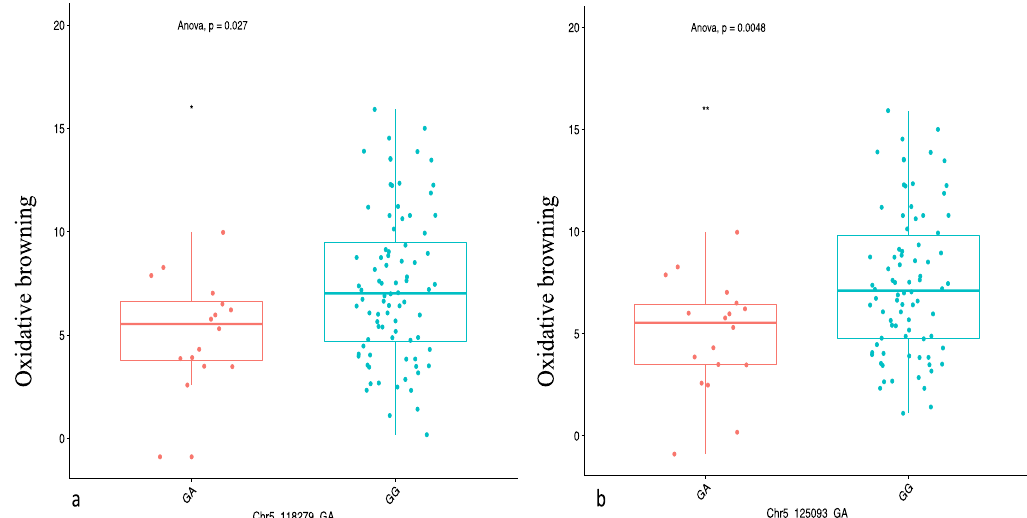
Figure 6. Marker effect of the significant markers associated with OxB on chromosome 5 with two markers: ( a ) chr5_118279 and ( b ) chr5_125093. The letters on the X-axis represent allele variants (GA and GG). Significant codes: ** = 0.01; * = 0.05 and p represents the ANOVA probability value associated